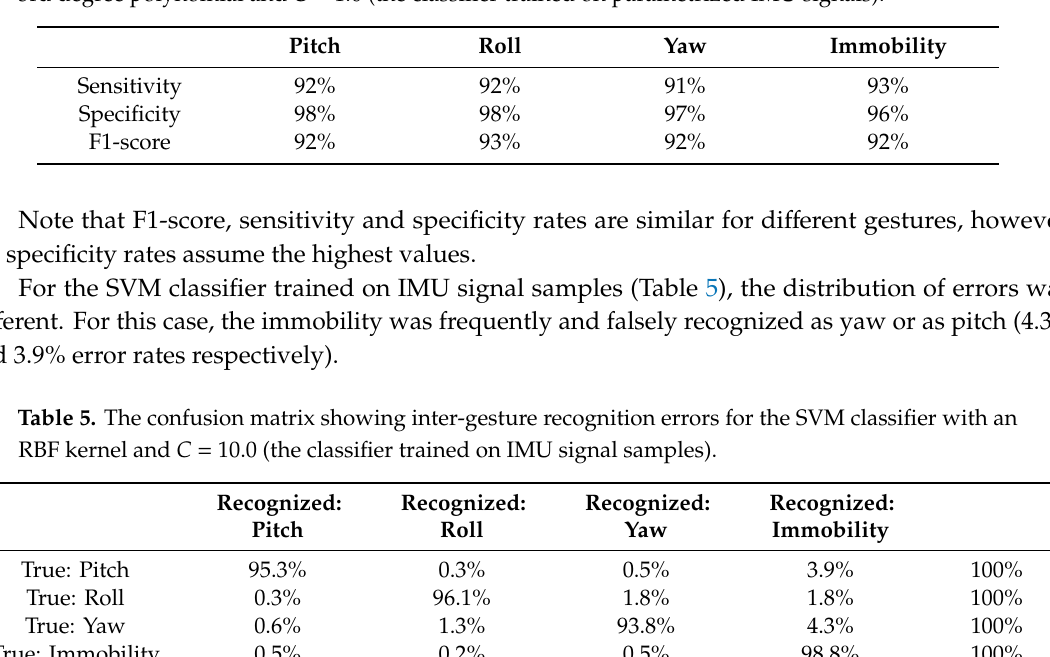
Table 4. Statistical measures showing detection results of head gestures for the SVM classifier with a